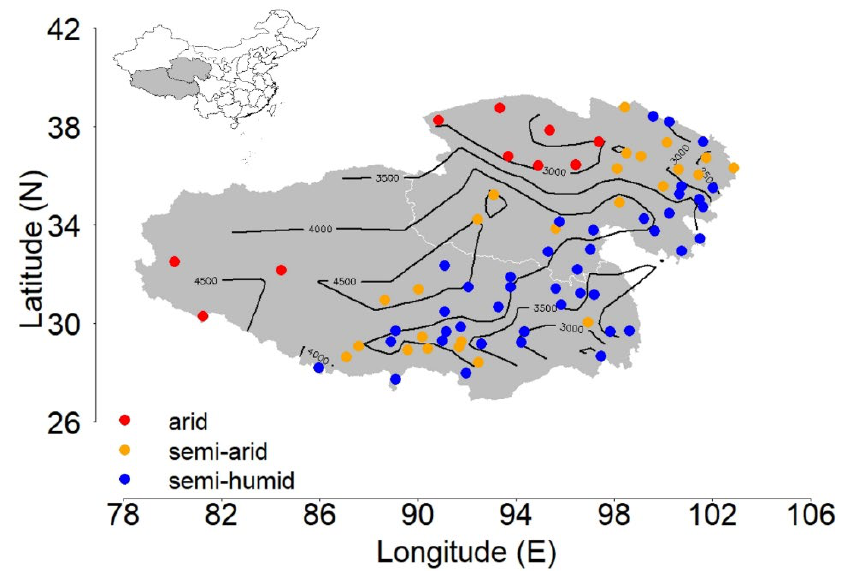
Figure 1. The locations of 78 meteorological stations on the QTP. Altitudes (contours) and precipitation zoning (circles) are given for these stations.